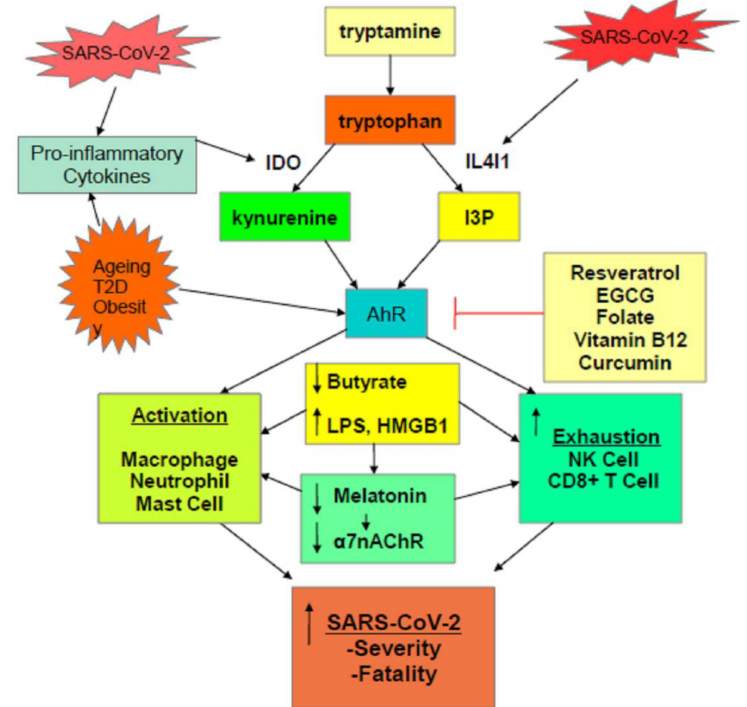
Figure 1. Scheme showing how the SARS-CoV-2 virus, and pre-existent high-risk medical conditions, shift tryptophan metabolism to increase AhR ligands. The activation of the AhR alters the nature of the initial ‘cytokine storm’ and sup- presses the endogenous antiviral responses of NK cells and CD8+ T cells, leading to a prolonged activation of macrophages, neutrophils, and mast cells, as evident in severe SARS-CoV-2 infection. The driving to tryptophan to kynurenine and I3P, along with the elevated pro-inflammatory cytokines of the ‘cytokine storm’, also suppresses pineal melatonin produc- tion and therefore the induction of the α 7nAChR by melatonin, thereby contributing lost vagal dampening of immune activity and raising sympathetic nervous system activation. The elevation in pro-inflammatory cytokines also increases gut dysbiosis/permeability, leading to a decrease in butyrate and raising LPS levels, further contributing to metabolic dysregulation of patterned immune responses to SARS-CoV-2 infection. A number of readily available nutraceuticals, such as resveratrol, EGCG, folate, vitamin B12, and curcumin, by AhR inhibition, may act to modulate how many processes influence SARS-CoV-2